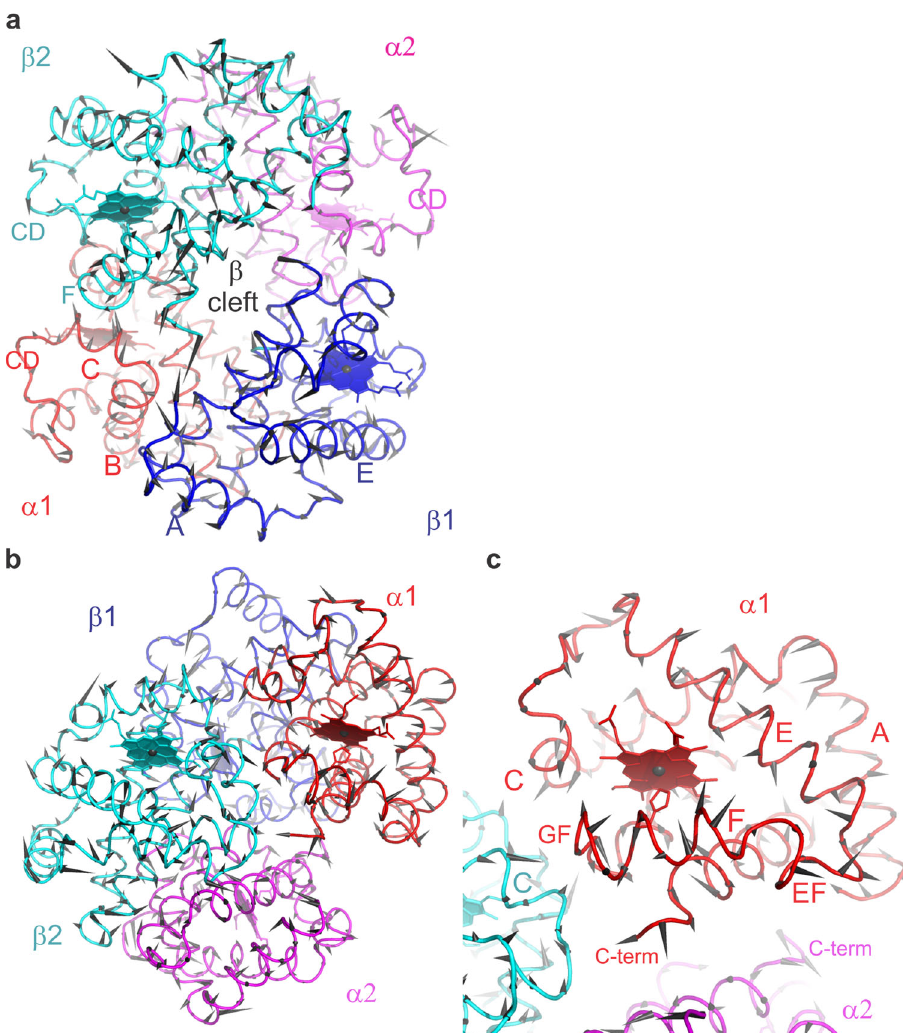
Fig. 4 Structural comparison of the single-pulse and pump – probe Hb.CO structures. The displacement between respective C α positions is indicated by black arrows. The magnitude of the displacement is illustrated by the length of the arrows (multiplied by a factor of 10). a , b Different orientations of the haemoglobin tetramer. The fact that clusters of arrows point in similar directions shows that the displacements are correlated both within and between secondary structure elements. To ease visualization of the displacements, Supplementary Movie 4 shows a morph between the two structures. The proximal histidines are shown as sticks. c A magni fi ed view of the α 1 subunit (similar orientation as in b ). Correlated displacements of the F helix towards the haem are clearly visible. a , b , c The alpha subunits are shown in red and magenta, beta subunits in blue and cyan. Helices are labelled by capital letters (A, B, C … ), loops between helices by the two letters corresponding to the respective helices (e.g., EF loop region connecting the E and F helices); haem planes are depicted as fi lled